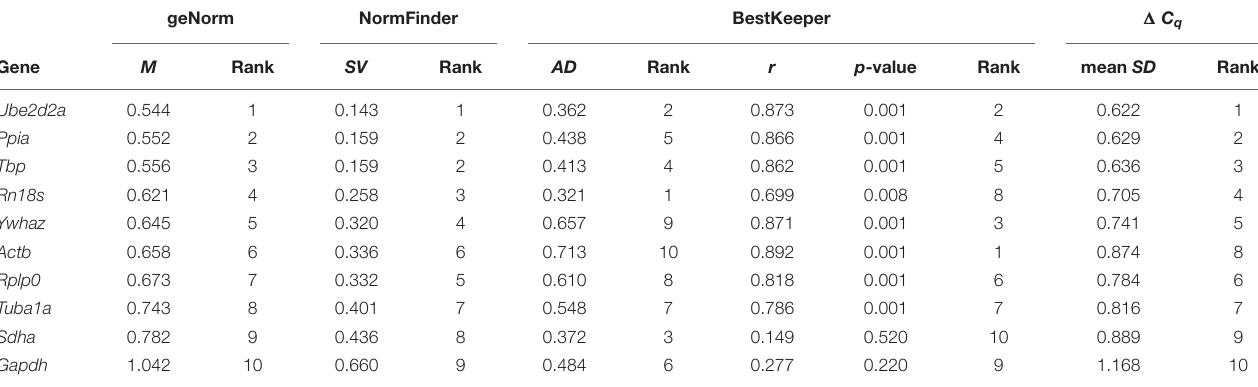
TABLE 1 | Gene expression variation and ranking of the bank vole genes. geNorm NormFinder BestKeeper (cid:49) C